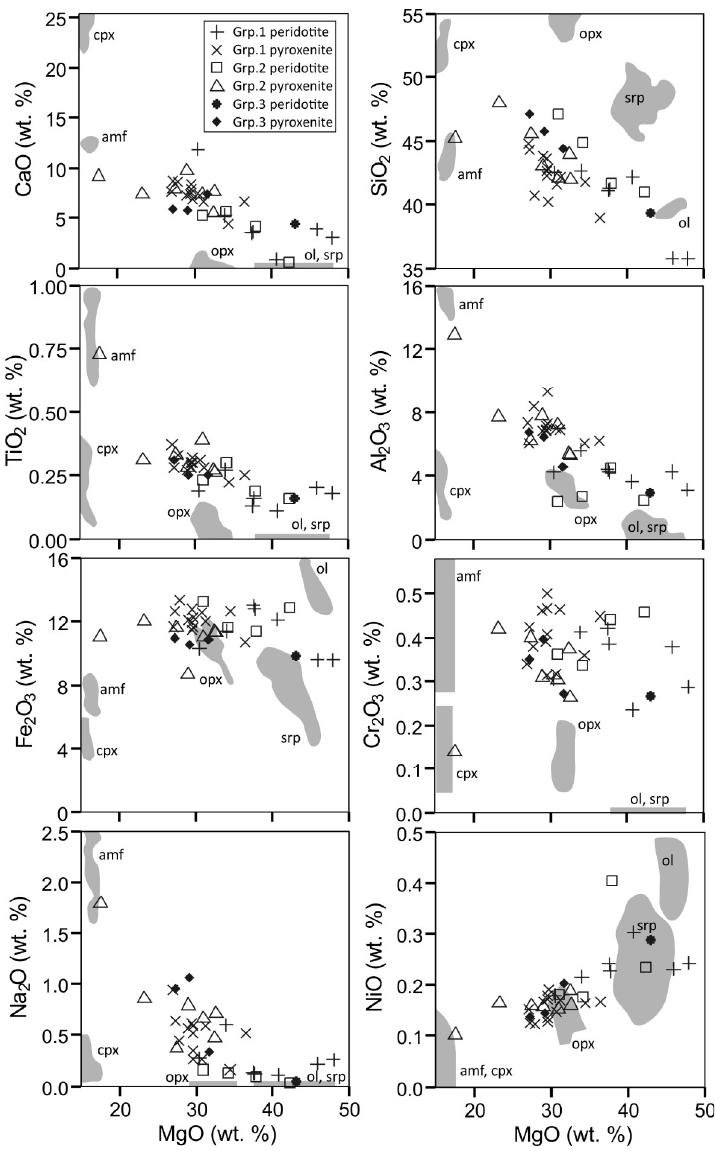
Figure 5. Bivariate plots detailing the major and minor element compositions of the Ben Strome samples, with grey mineral chemistry field included for reference. Note: amphibole fields are after Guice et al. [45]. Abbreviations: amf = amphibole; cpx = clinopyroxene; ol = olivine; opx = orthopyroxene; srp = serpentine.